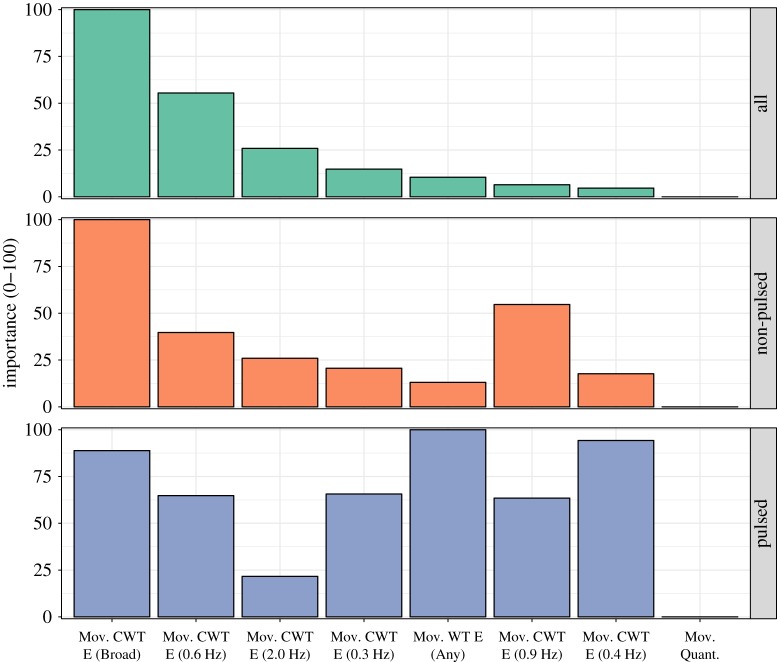
Normalized predictor importance values for the eight predictors in the random forest model across the datasets.